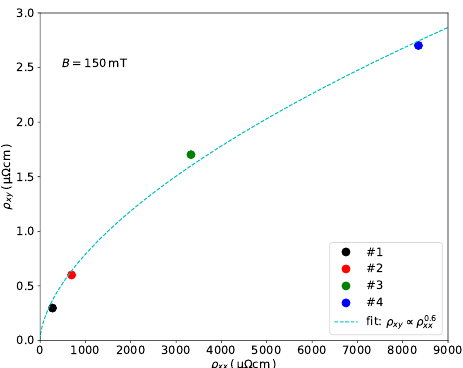
Figure 3. Hall resistivity ρ xy vs. longitudinal resistivity ρ xx as deduced from the data of samples #1 to #4 taken at room temperature in an applied magnetic flux density of